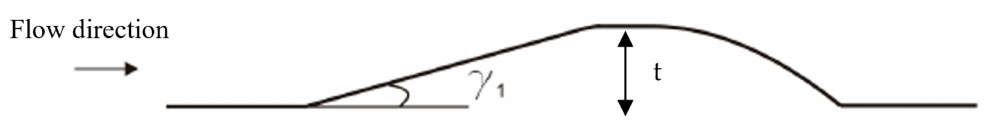
Figure 9. Geometrical shape of the wave-shaped bump, cross section at an angle of 90 degrees to flow